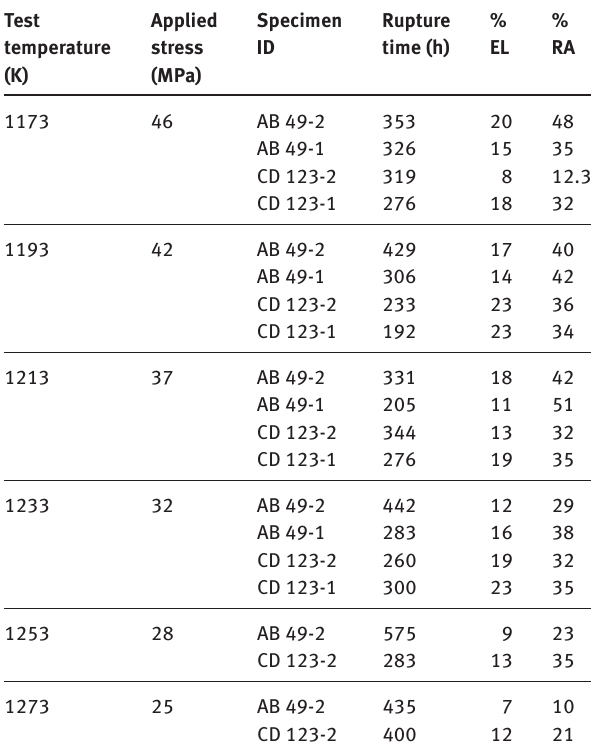
Table 7: Accelerated creep rupture test results for tube samples